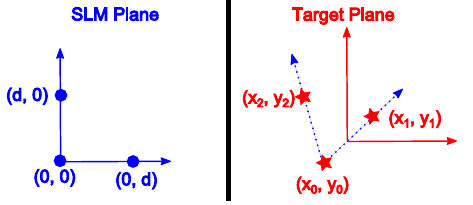
FIG. 2. Coordinate systems of both the SLM and target planes, showing a possible skew transformation between the